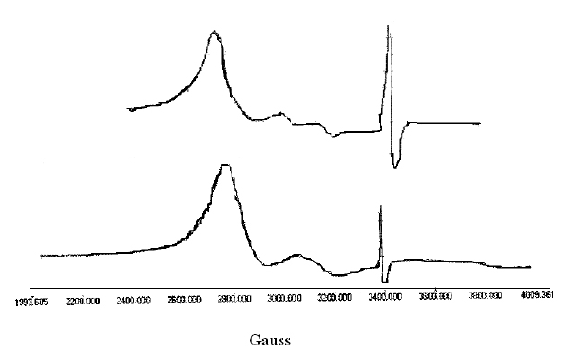
Table 6. Antibacterial activity of ruthenium(III) complexes a